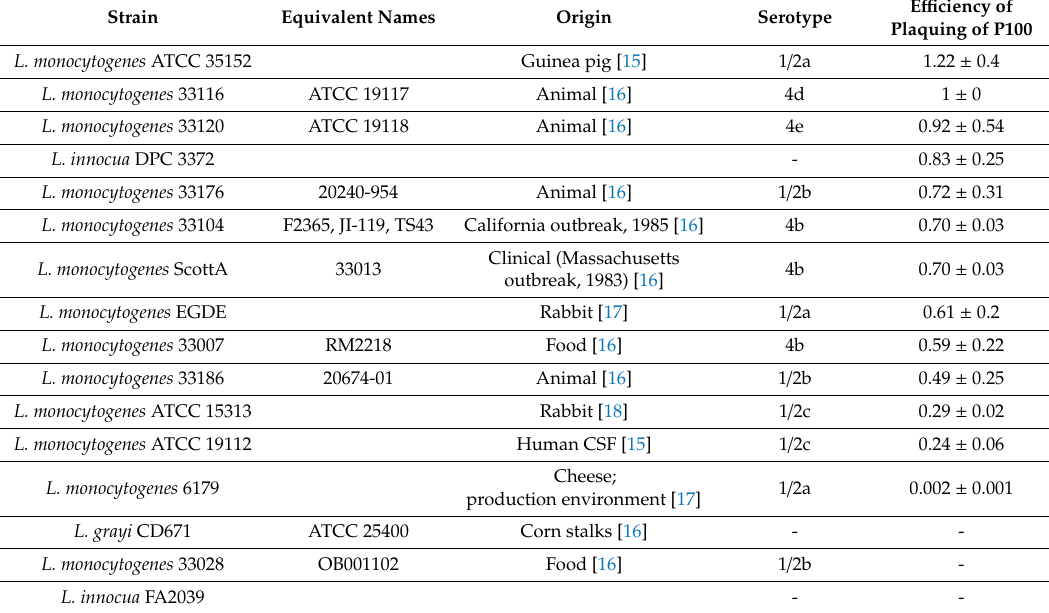
Table 1. Listeria strains used and their sensitivity to phage P100. E ffi ciency of plaquing is represented as a fraction with standard error of the mean (SEM) of three separate experiments. If no P100 plaques formed on a strain, e ffi ciency of plaquing is represented by